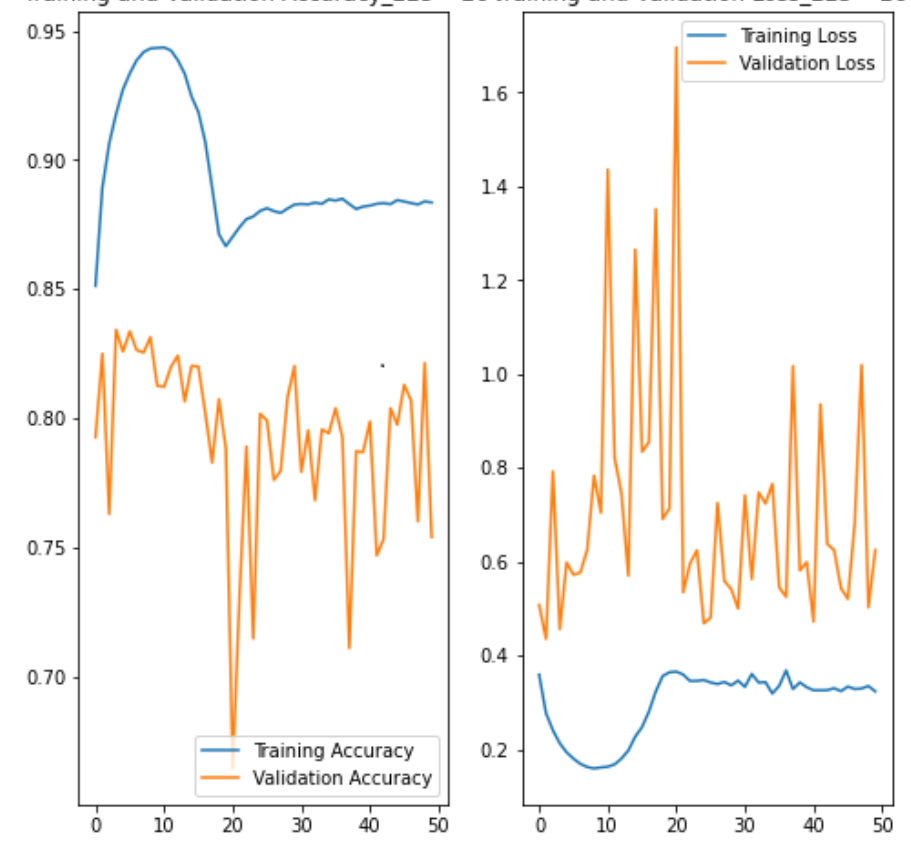
Figure 4. Training/validation loss and accuracy for image size 225 ×